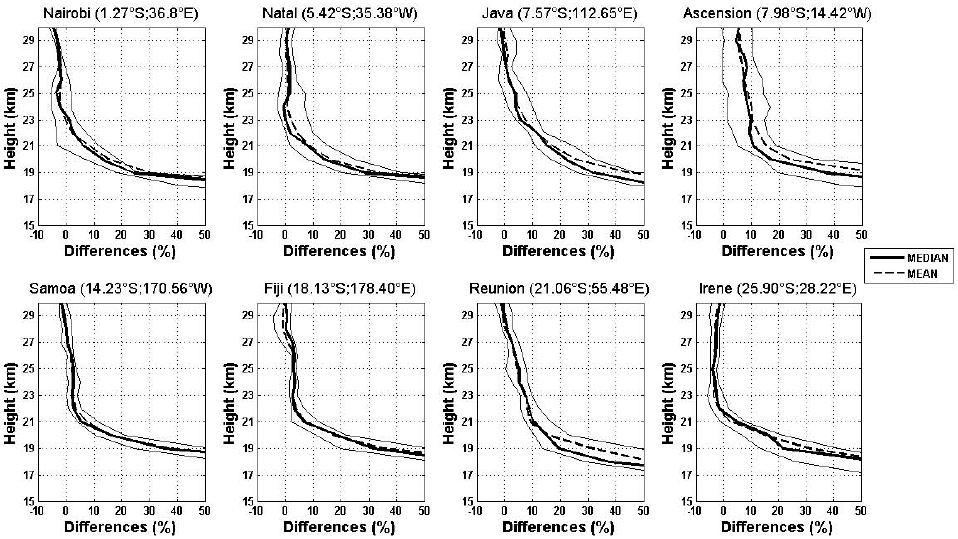
Fig. 6. Median (thick continuous lines) and mean (dashed lines) for all monthly comparisons between GOMOS and SHADOZ ozone mixing ratios, for altitudes between 15km and 30km. The thin continuous lines refer to the 25th and 75th percentiles for the median of the percentage